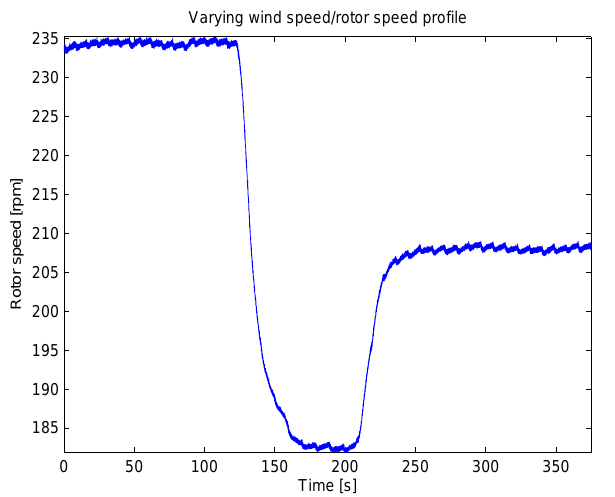
Figure 19. Actuator duty cycles of optimised controller (post- flutter).